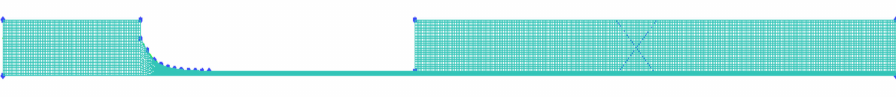
Figure 4. The overall mesh of the simulation